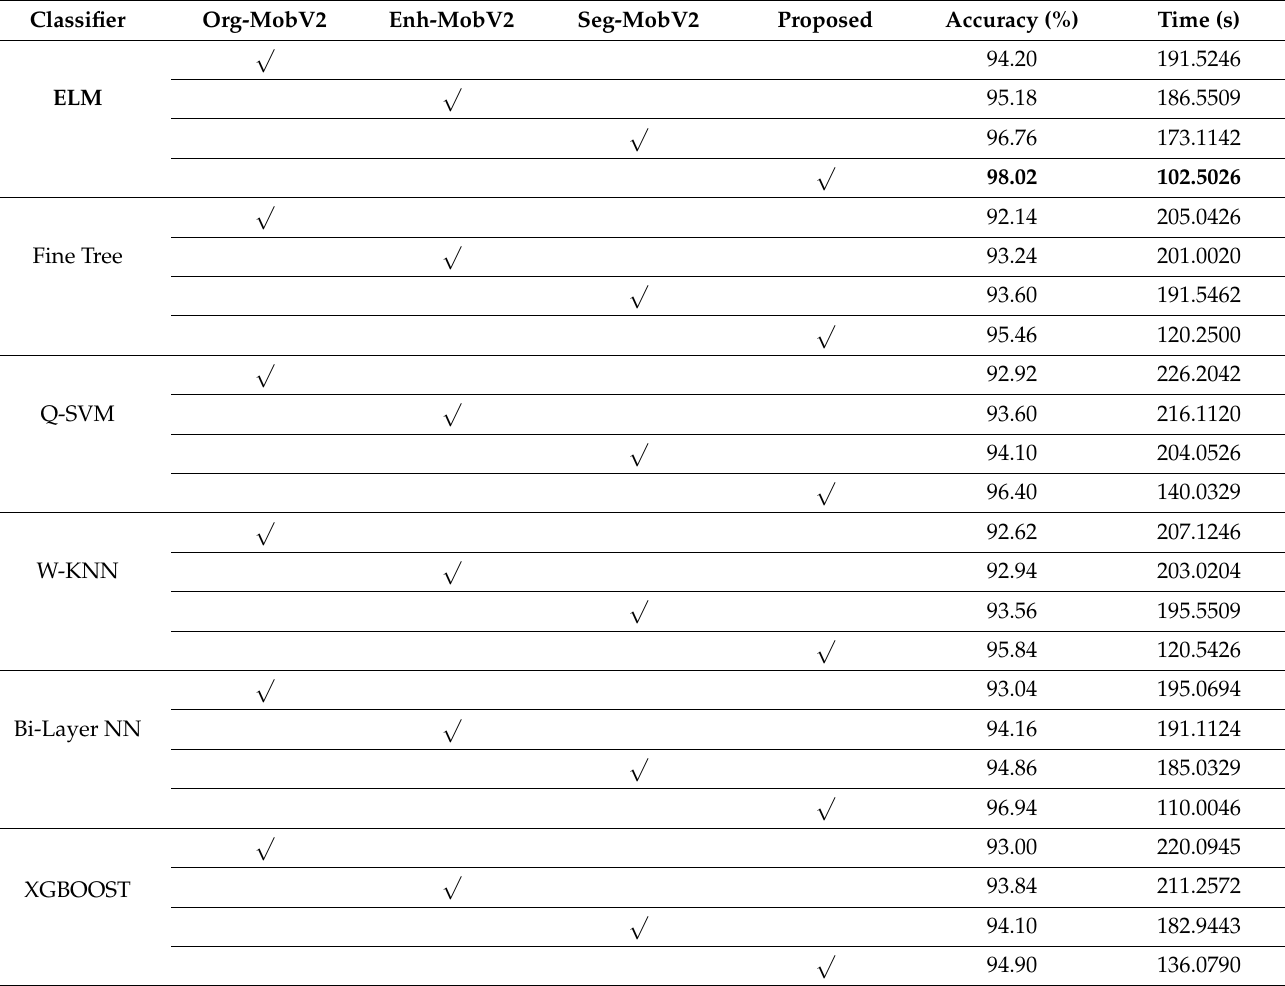
Table 3. Proposed framework classification results on Kvasir V2